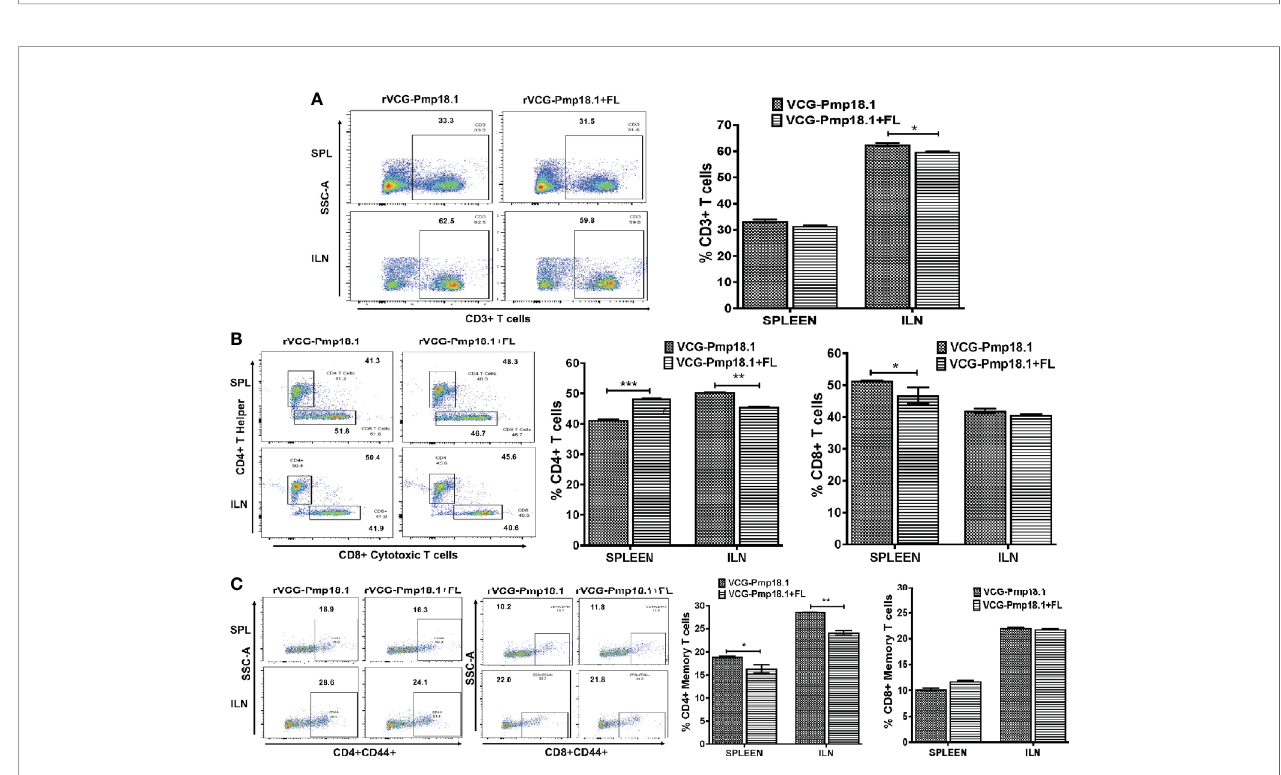
FIGURE 6 | Immunization of mice with rVCG-Pmp18.1 vaccine with and without FL adjuvant induced immune CD4+ and CD8+ T cell in fi ltrating into mucosal and systemic tissues of immunized mice. Single cell suspensions were isolated from harvested spleens and ILN obtained from immunized mice as described above. Isolated cells were labeled with anti-CD4, -CD8, -CD4+CD44+ and – CD8+CD44+ antibodies and analyzed by fl ow cytometry. Representative fl ow cytometric images (left) and bar graphs (right) showing percentages of CD3+ T cells (A) , CD4+ and CD8+ T cells (B) and CD4+CD44+/CD8+CD44+ (C) memory cells. Data are shown as mean ± SD and represent two independent experiments ( fi ve mice in each group) with similar results. * p < 0.05, ** p < 0.01, *** p < 0.001.